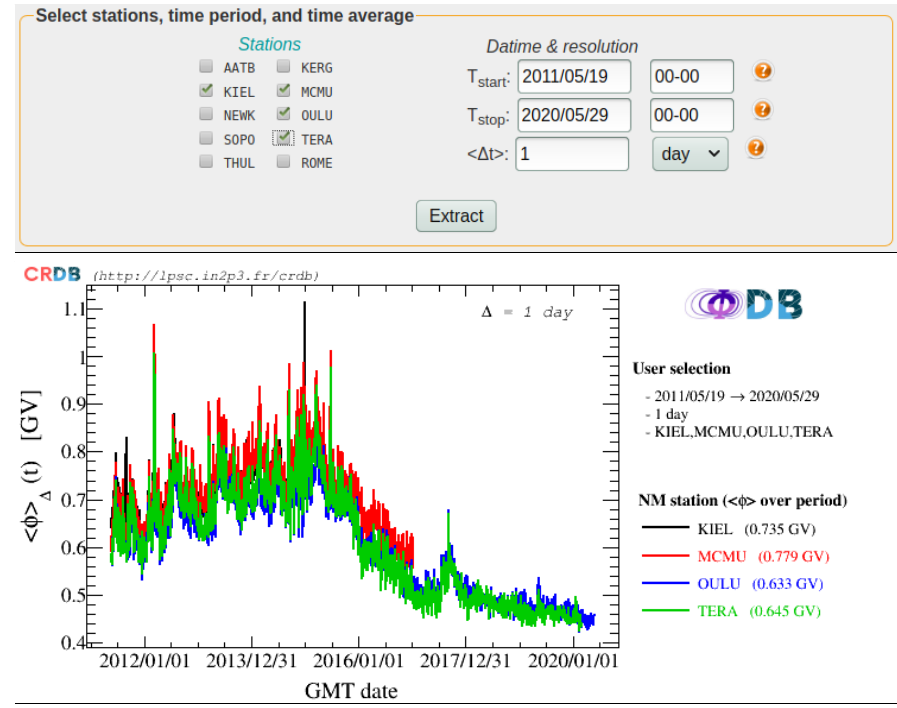
Figure 9. Illustration of φ time series retrieved from the ‘ φ from NM’ tab, based on the calculation of Ghelfi et al. [1]. The top panel shows the user-selection for NM stations (OULU, KIEL, MCMU, and TERA) and time interval 2011/05 to today, corresponding to the time since AMS-02 was installed on the ISS. The bottom panel shows the resulting daily averaged values (cid:104) φ (cid:105) d ( t ) as coloured lines for different